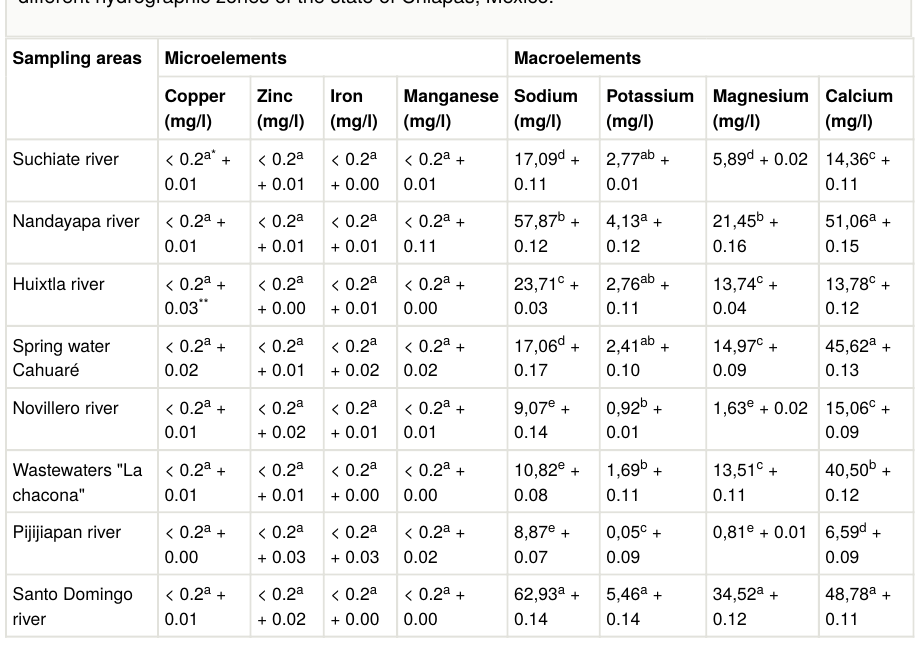
Evaluation of the concentration of macroelements and microelements of water samples from the di ff erent hydrographic zones of the state of